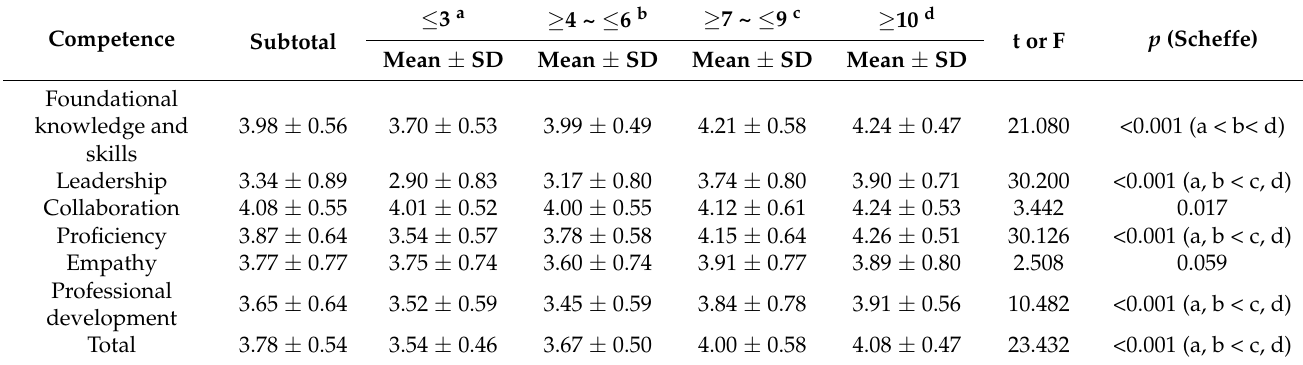
Table 2. Levels of perioperative competencies and differences among clinical ladders.